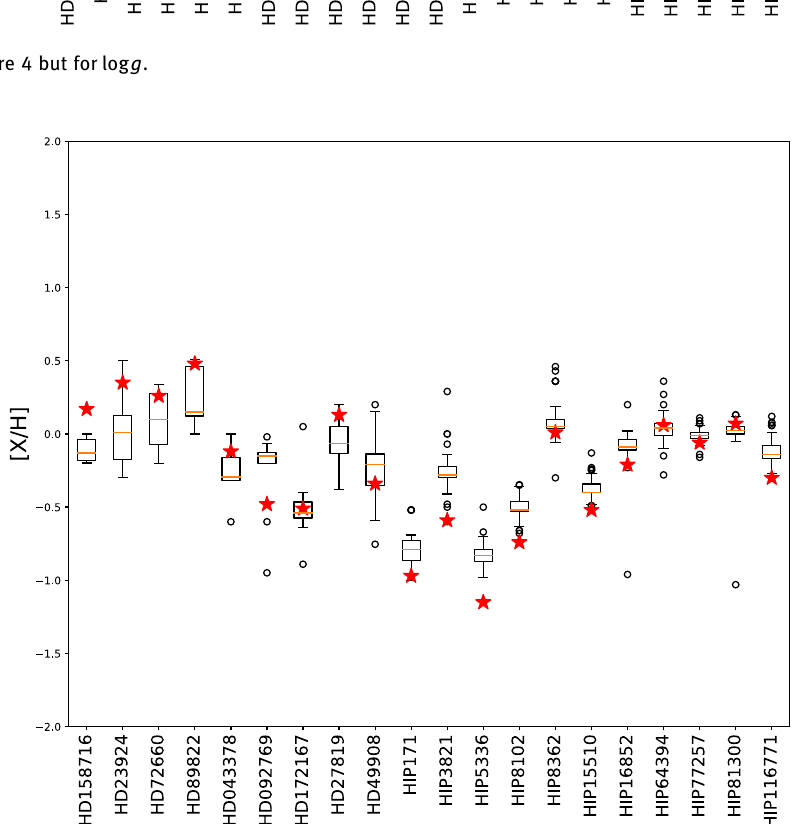
Figure 6: Same as Figure 4 but for [ ] / M H